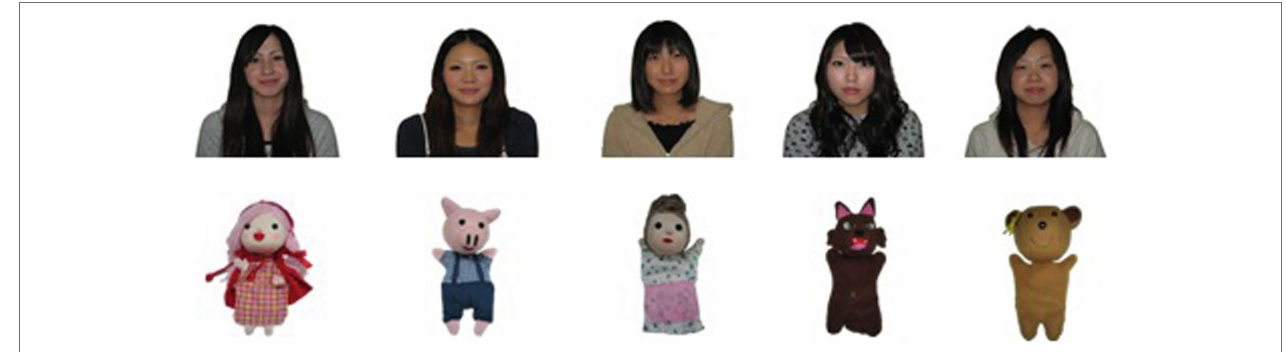
FIGURE 1 | Examples of stimuli used in the study (dolls and their makers). For example, dolls of a little girl with a red hood, her grandmother, a hunter, and a wolf were made for “Little Red Riding Hood.” Printed with written permission from the